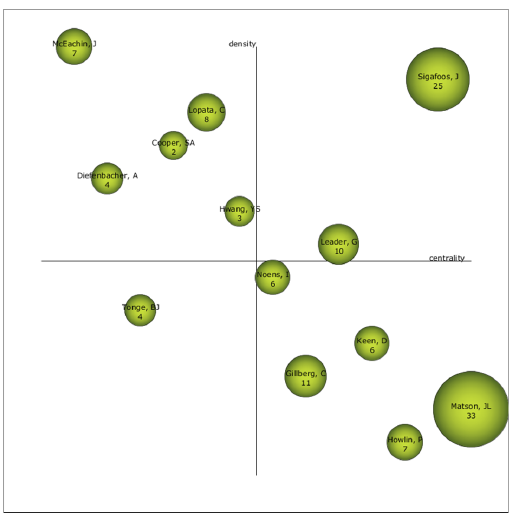
Figure 6. Strategic diagram of the author of all the productions by index h.